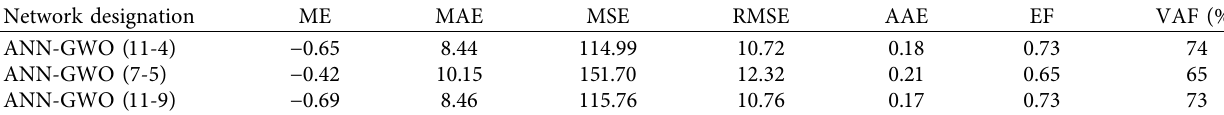
Table 9: Statistics of top 3 seven-input ANN-GWO models on training data.